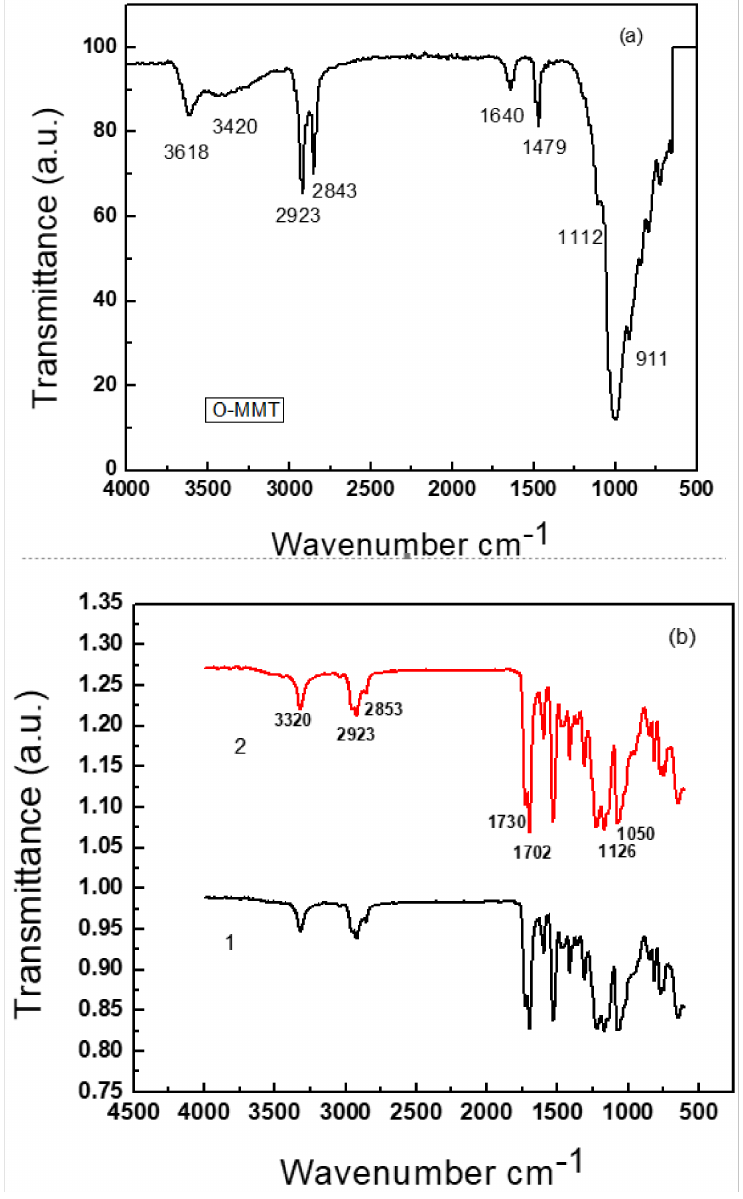
Figure 2. FTIR spectra of the ( a ) organo-modified montmorillonite clay (O-MMT) and ( b ) the TPU -fillers nanocomposites: (1) TPU-1 and (2)